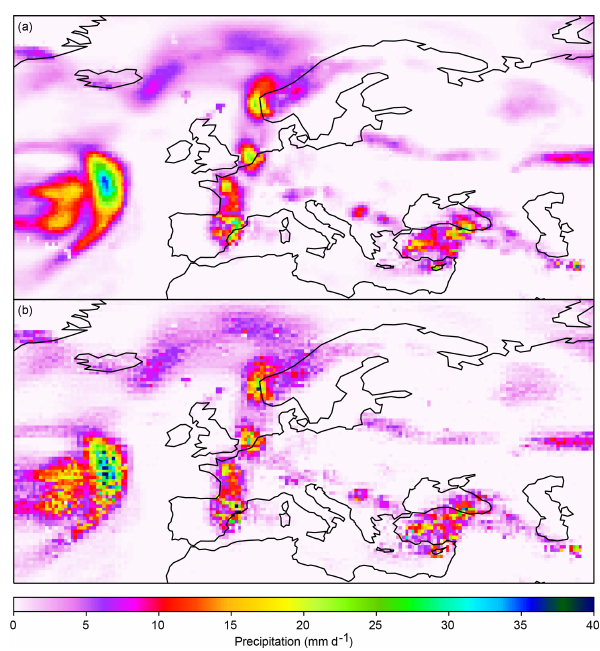
Figure 6. Statistical downscaling of precipitation from 1 to 0 . 5 ◦ spatial resolution using different broadcasting methods in step 1 of the MBCnSD algorithm. In this example, the algorithm is applied for statistical downscaling of spatially aggregated historical obser- vation data. Shown are downscaled precipitation fields over Europe for one particular day, using bilinear and conservative interpolation for broadcasting in panels (a) and (b) , respectively. The correspond- ing original precipitation field is shown in panel (a) of Fig.